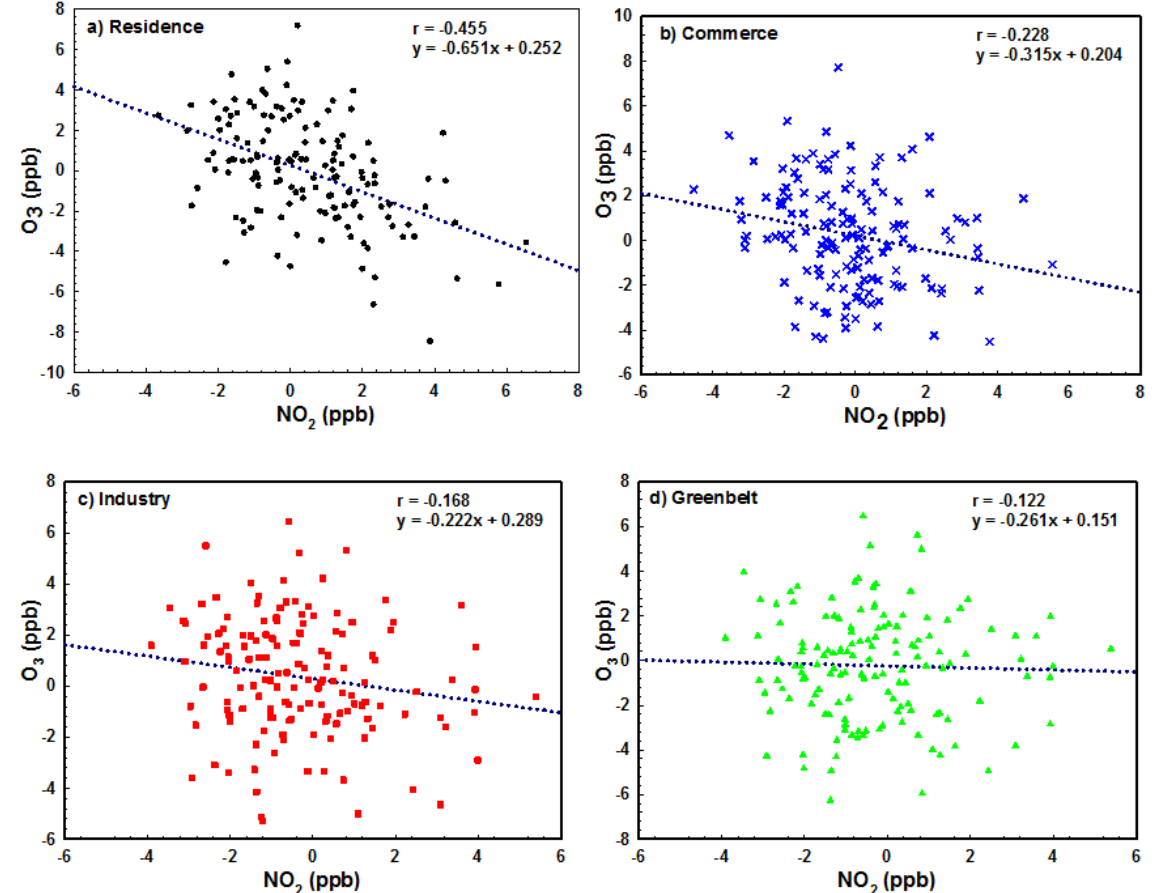
Figure 8. Scatter diagrams of the monthly anomalies of O 3 (ppb) versus NO 2 (ppb) in South Korea during the period from January 2002 to December 2013 under the four land-use types; (a) residence (black circle), (b) commerce (blue cross), (c) industry (red square), and (d) greenbelt (green triangle). The correlation coefficient ( r ) and the regression dotted line are also